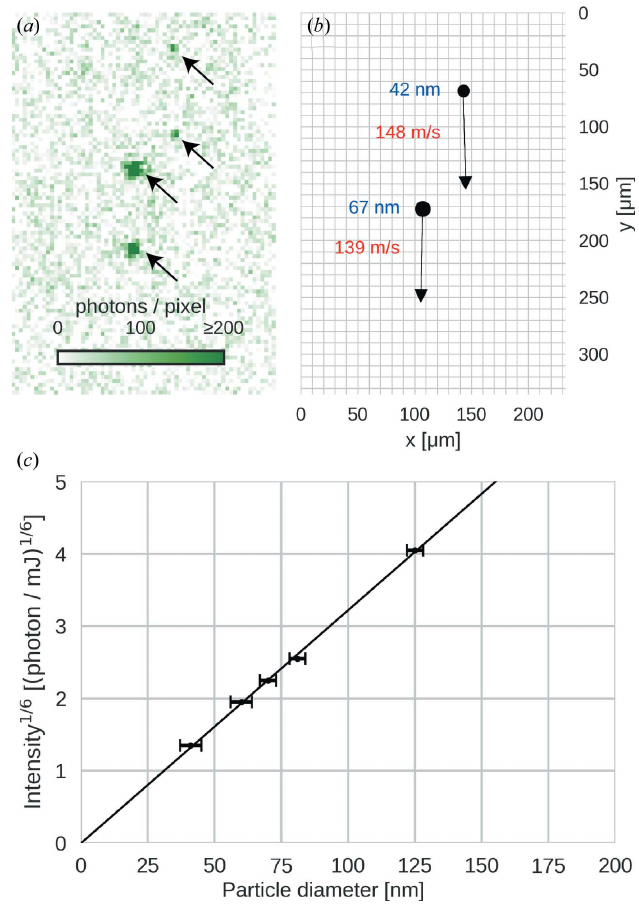
Figure 2 Quantitative analysis of Rayleigh-scattering-microscopy data. ( a ) Double-exposure image of two polystyrene spheres of different diameters. The pulse delay was 50.8 m s and the pulse energy 56.1 mJ. ( b ) Extracted particle positions, velocities and diameters from the image shown in ( a ). ( c ) The sixth root of the mean integrated scattering intensity per particle (rescaled to 1 mJ laser-pulse energy) is plotted against the diameter of the respective polystyrene-sphere size standard. The values follow Rayleigh’s scattering law (solid